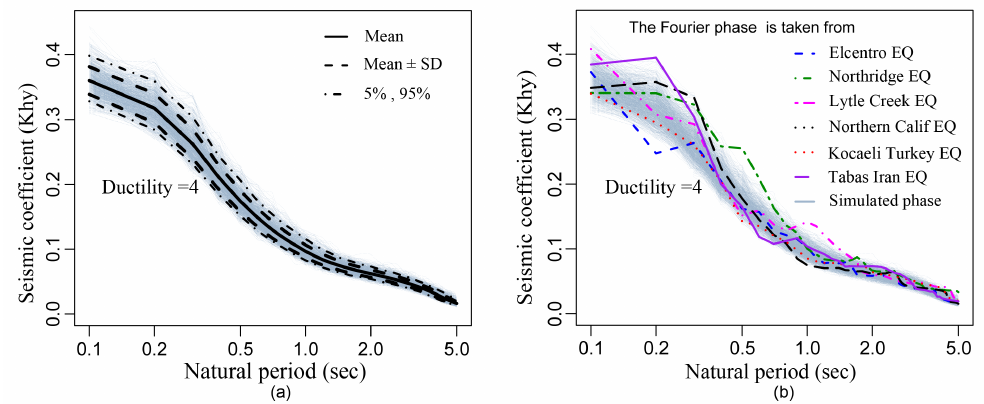
Figure 11. YSC demand spectra obtained by simulated 1000 DRSCEMs using modified fBm process, ( a ) Mean, mean plus and minus one standard deviation, 5 and 95 percentile confidence intervals and ( b ) Comparison with results obtained by using DRSCEM simulated by observed ground motion